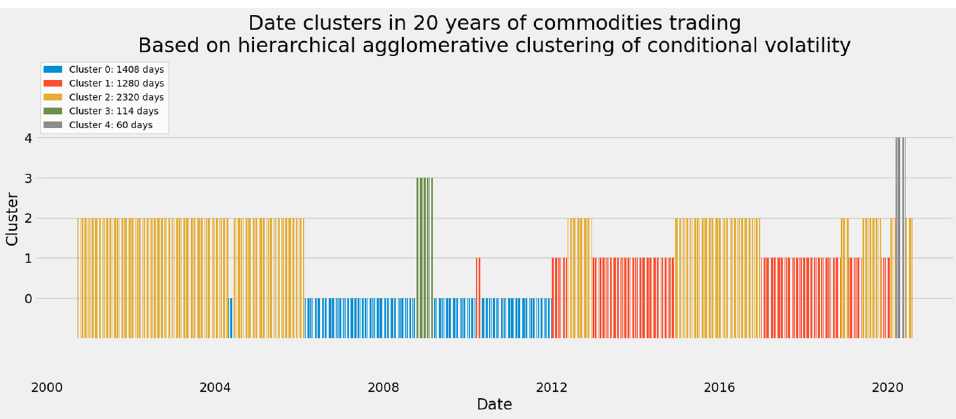
Figure 12. Hierarchical agglomerative clustering of commodity markets—An ordered timeline.